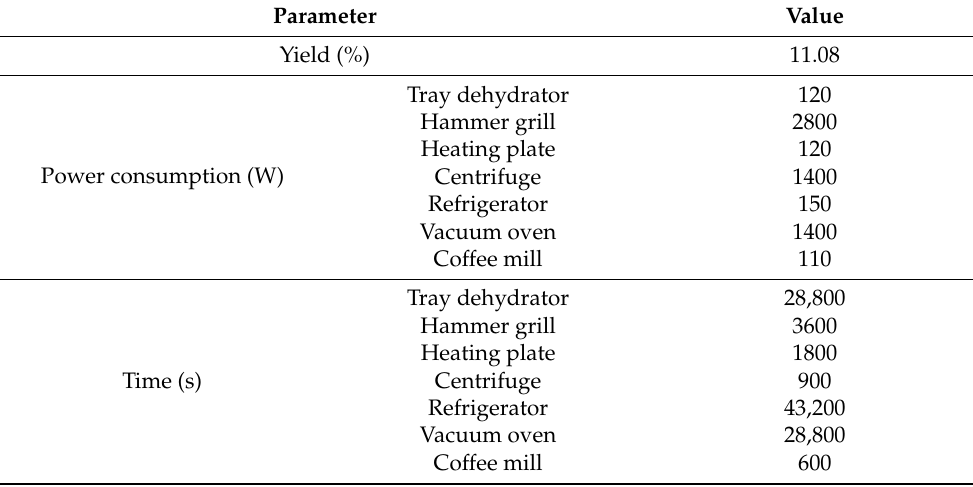
Table 6. Power consumption and economic analysis to produce 1 kg of Haden mango peel